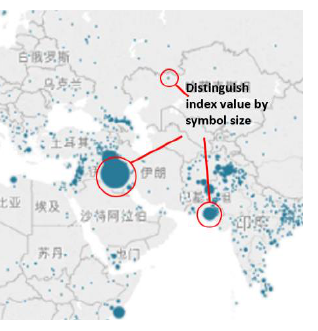
Figure 6 A trend analysis composite chart based on Cartesian coordinates